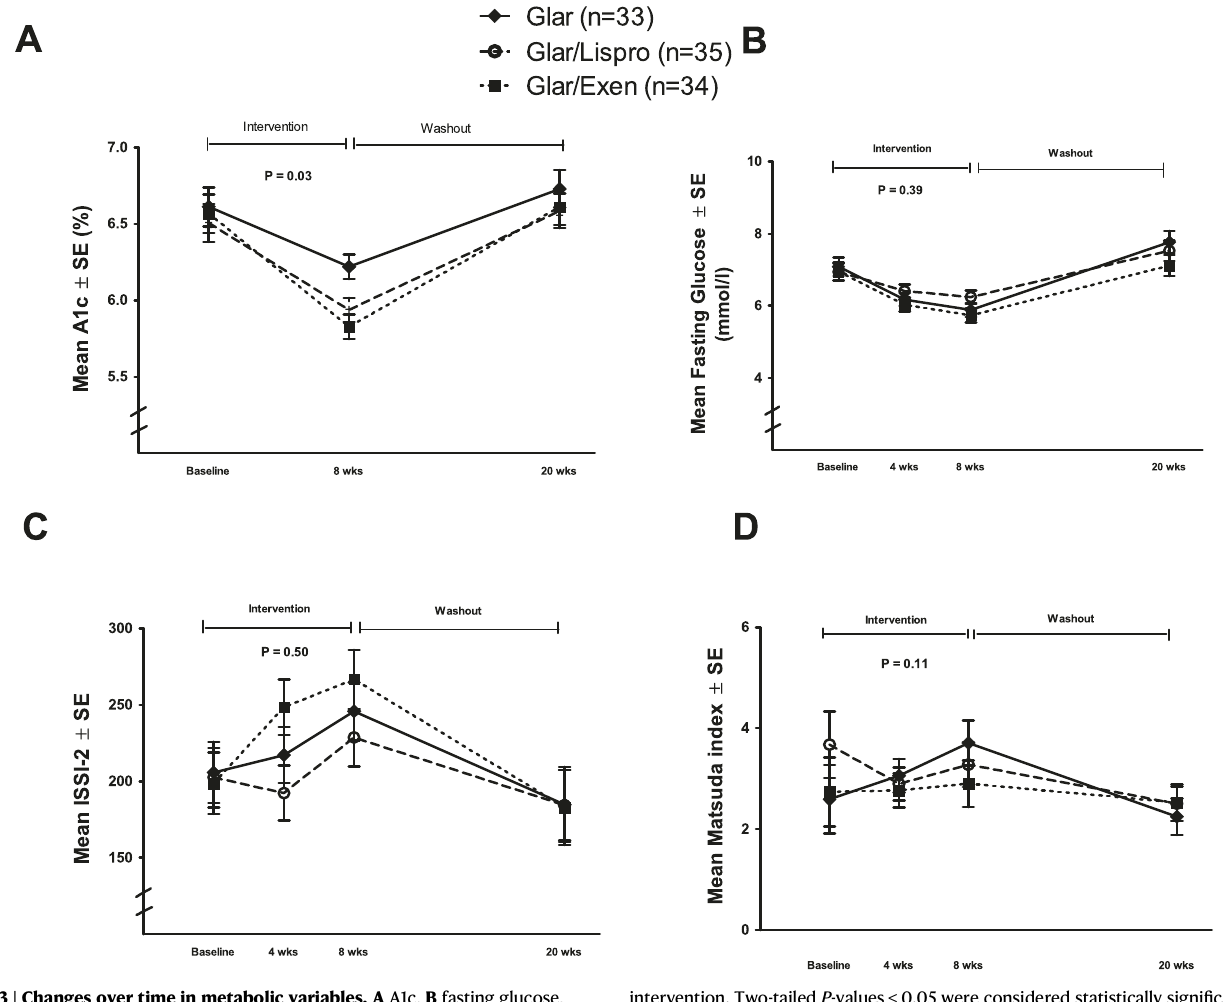
Fig. 3 | Changes over time in metabolic variables. A A1c, B fasting glucose, C Insulin Secretion-Sensitivity Index-2 (ISSI-2), and D Matsuda index. Data are presented as mean values±standard error. Generalized estimating equation (GEE) model was used to test time-treatment interaction effect during the 8-week